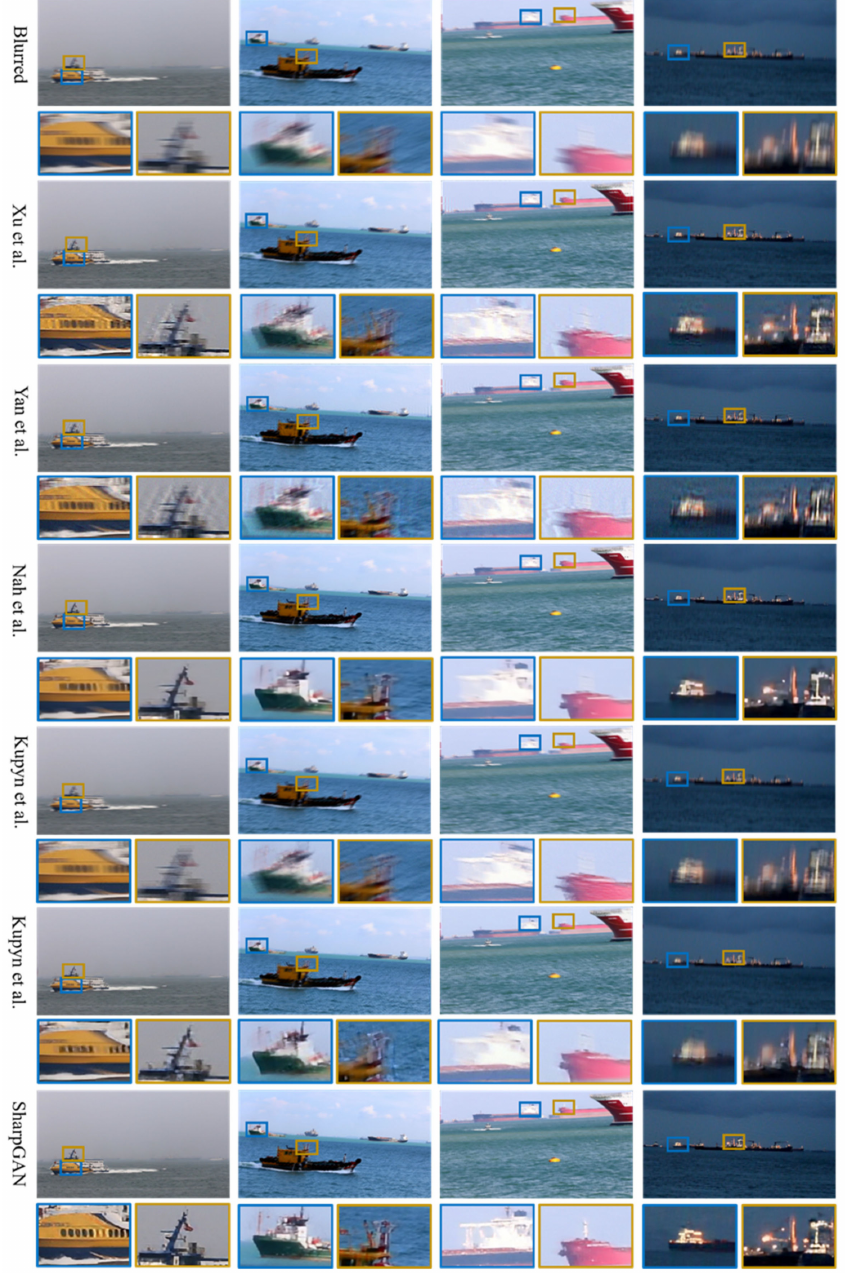
Figure 5. The deblurring results of SMD dataset [32]. From top to bottom: blurred images, results of Xu et al. [7], Yan et al. [9], Nah et al. [12], Kupyn et al. [14], Kupyn et al. [23], and the results of